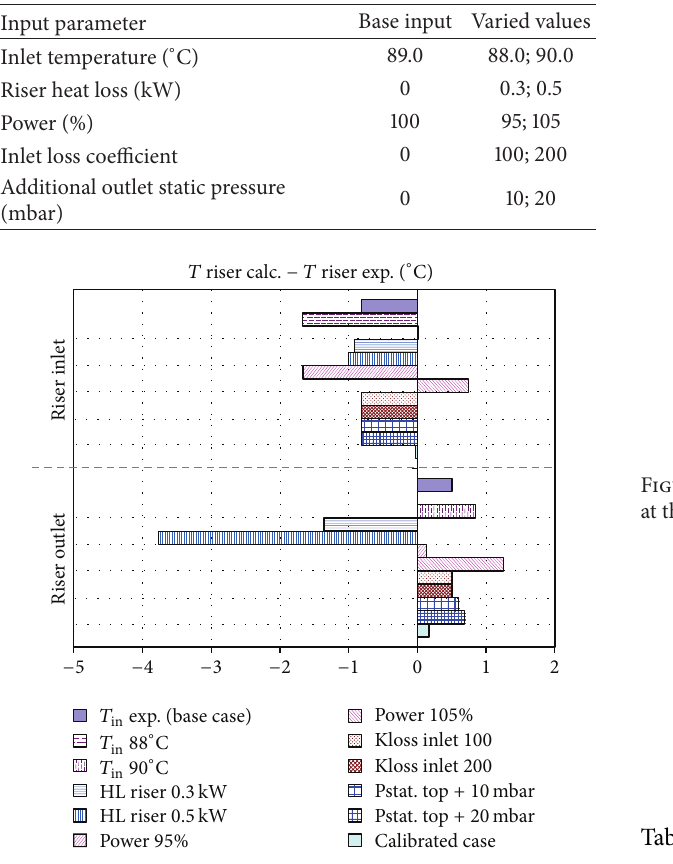
Table 2: Varied uncertain input parameters in the parametric study for the test section.